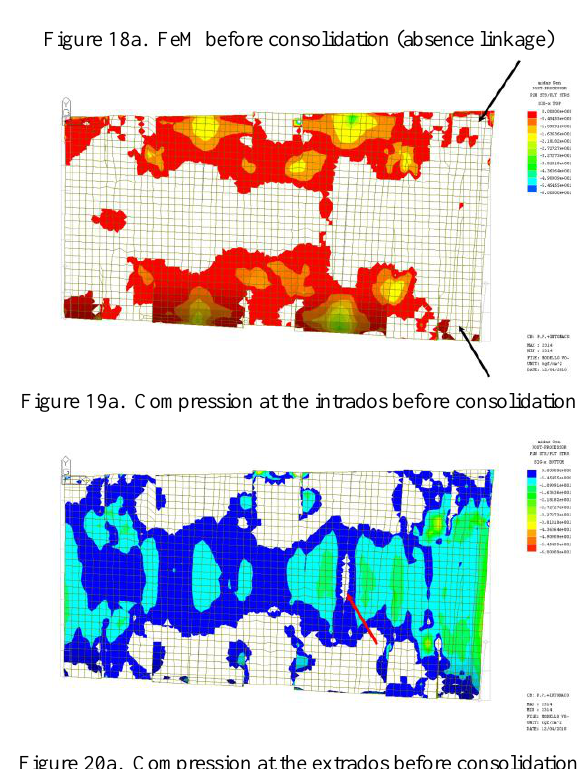
Figure 18b. FeM after consolidation (addition linkage)